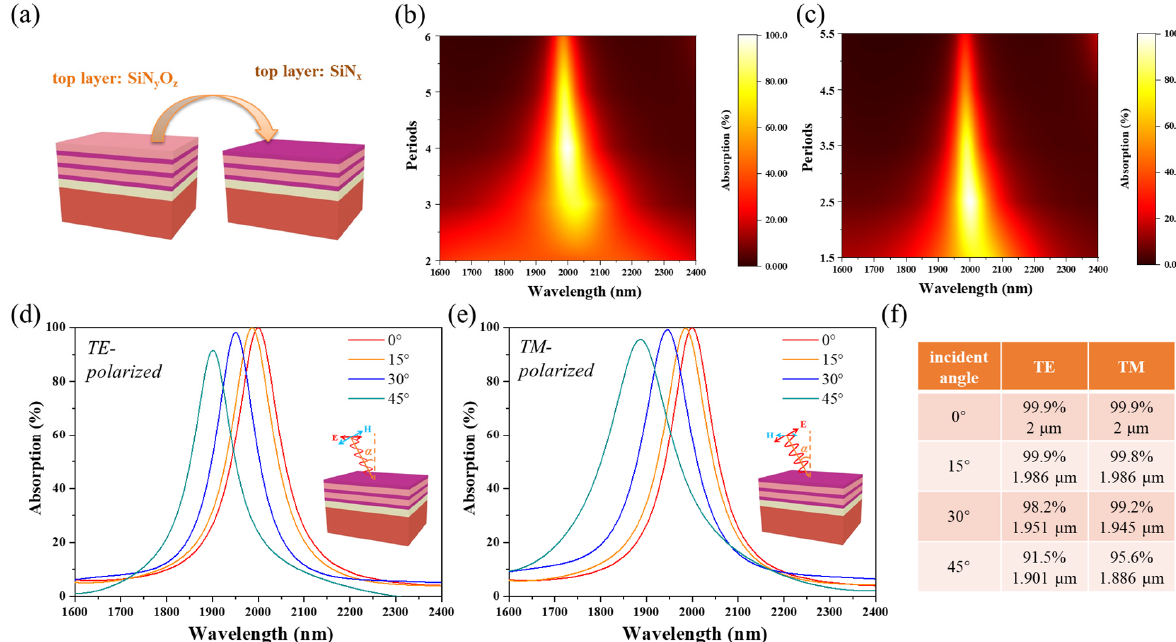
Figure 2. ( a ) Schematic diagrams of Si-W-SiN/SiNO emitters with different top layers. Simulated 2D absorption maps of Si-W-SiN/SiNO emitters with the absorption peak of TPP mode at 2 µ m; ( b ) the number of DBR periods from 2 to 6 with the top layer of SiNO film; ( c ) the number of DBR periods from 1.5 to 5.5 with the top layer of SiN film. Simulated absorption spectra of Si-W-SiN/SiNO emitters with top SiN layer with the incident light angles from 0 to 45 for different polarization states; ( d ) with TE polarization; ( e ) with TM polarization; ( f ) the accurate resonance center value and position of TPP resonance peaks in ( d , e ).